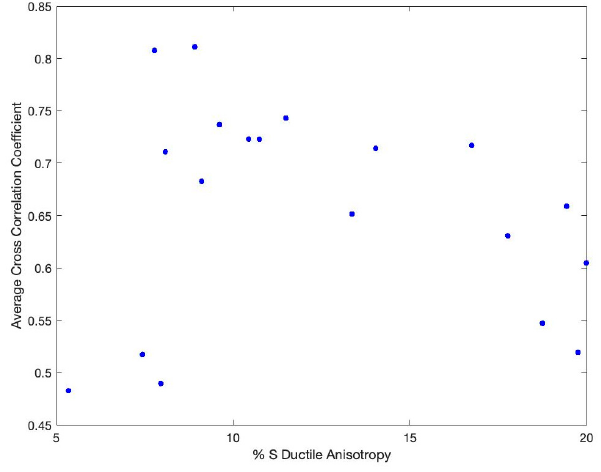
Figure A4. The average zero-lag cross-correlation coefficient drops markedly at low and high values for the lower crustal anisotropy.